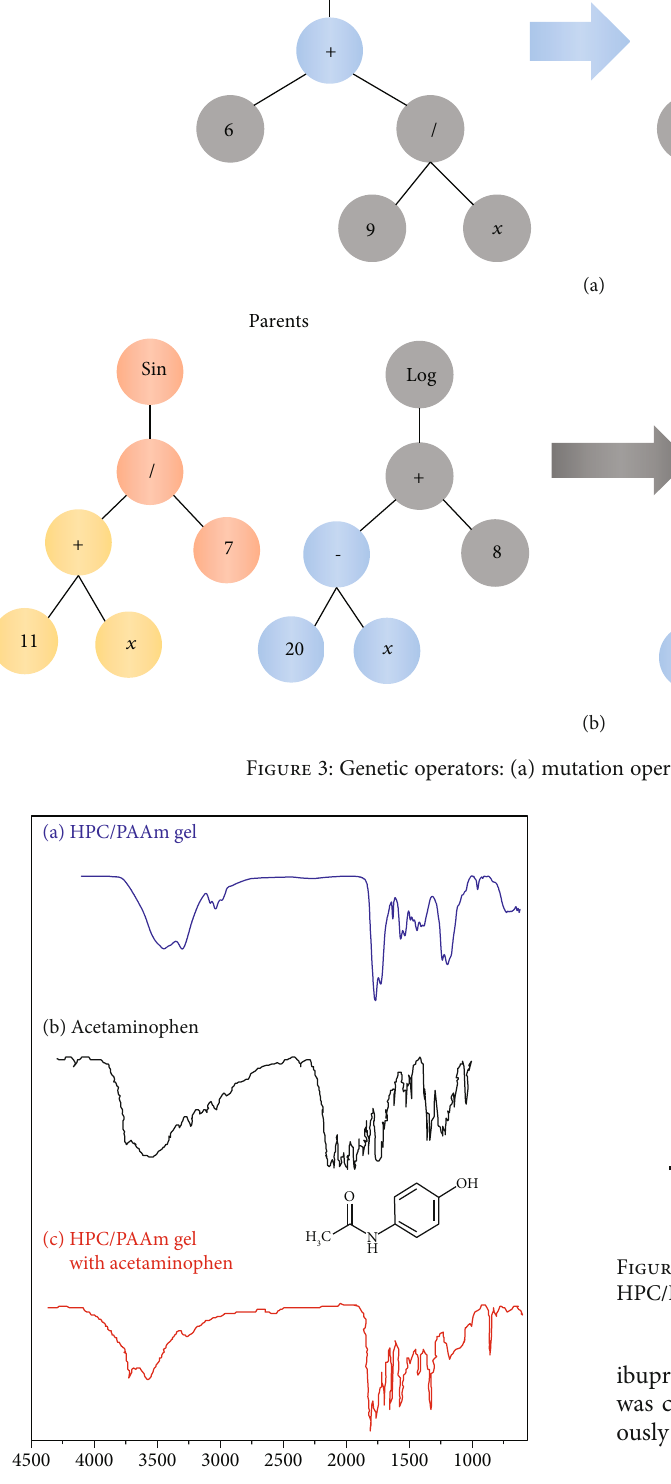
Figure 4: FTIR spectra of (a) HPC/PAAm gel, (b) acetaminophen, and (c) HPC/PAAm gel with incorporated acetaminophen.